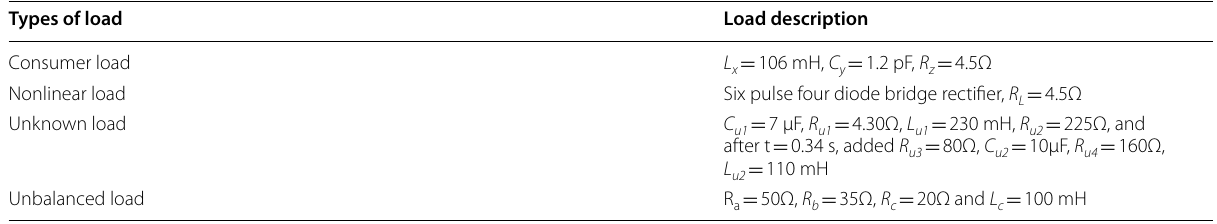
Table 12 Parameters of three‑phase load Types of